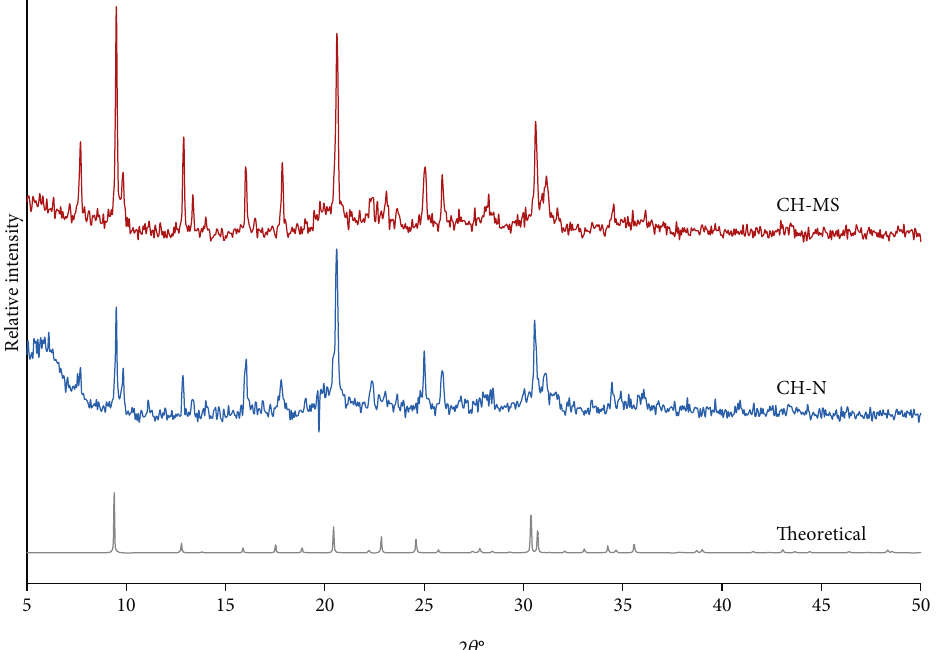
Figure 1: X-ray di ff raction patterns of CH-N and CH-MS. Label “ Theoretical ” corresponds to the calculated pattern from International Zeolite Association, which was used as a reference pattern. Table 1: Textural properties of CH-N and CH-MS samples.